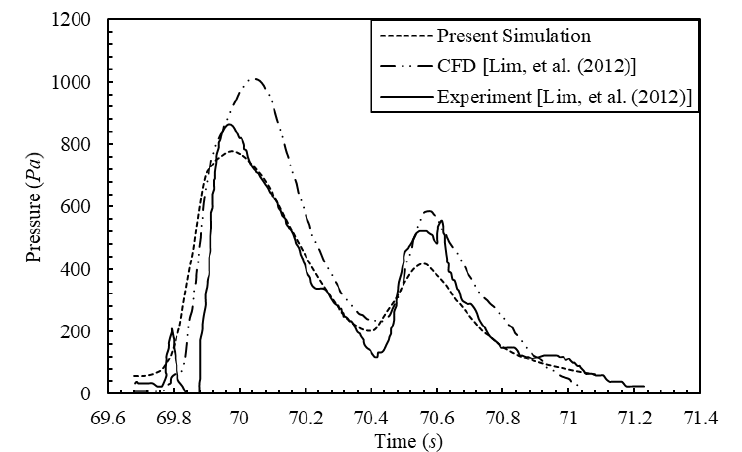
Figure 12. Comparison of pressures at location P4 on the deck ( Aw = 0.1125 m, λ = 3.75 m).